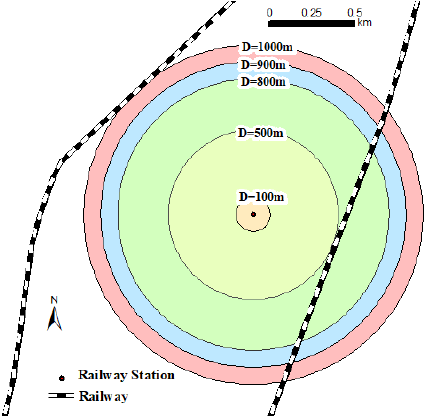
Figure A2. Schematic diagram of station buffer settings.